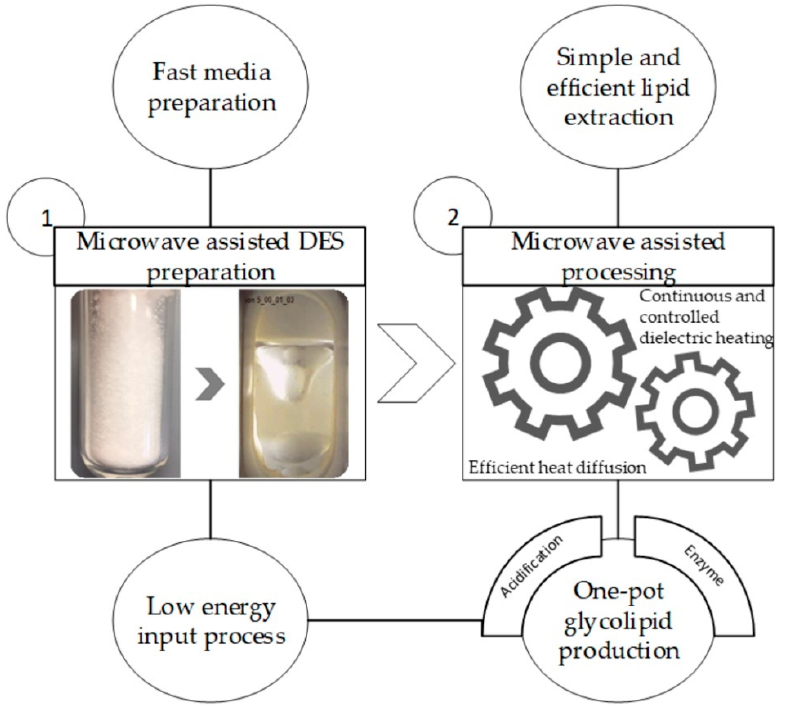
Figure 1. Flowchart of this study. Freeze-dried oleaginous biomass from S. podzolica was used in a one-pot microwave-assisted process that extracted fatty acids and subsequently produced a purifiable quantity of glycolipids when lipase and acidified Deep Eutectic System (DES) were jointly used. Previous work from Gorte et al. demonstrated, in this aim, the use of several meth- ods for the pre-treatment of the biomass produced by S. podzolica , including